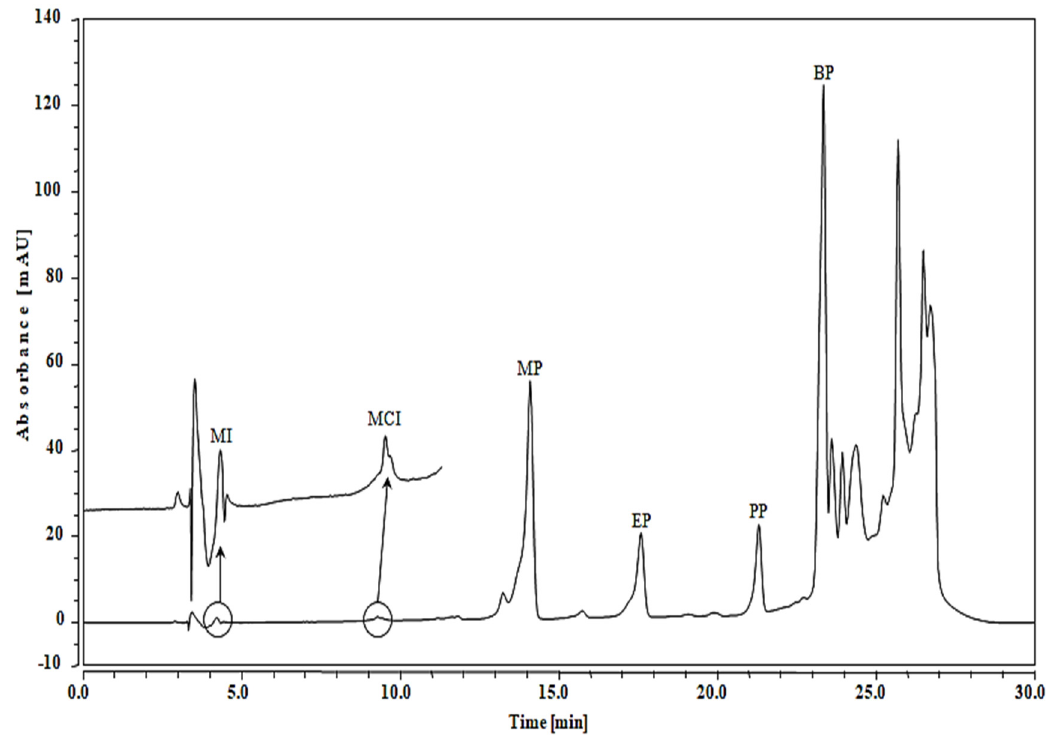
Figure 3. UHPLC/DAD chromatograms identified in perfumed body (dusting) powder (PP 3 , Max)